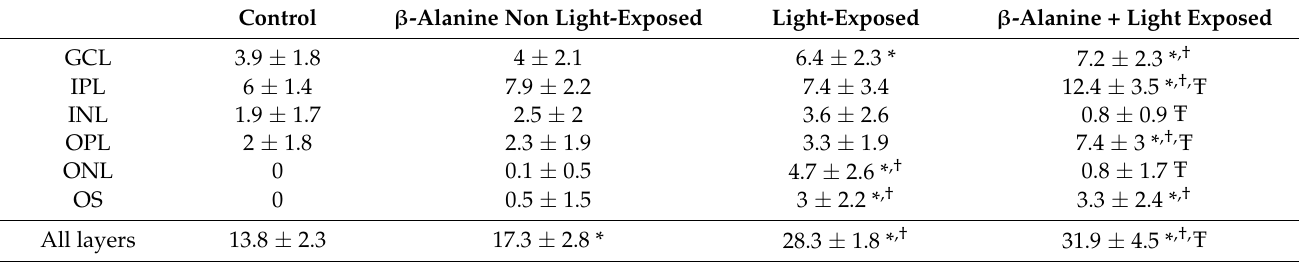
Table 3. Number of microglial cells per layer and total in control and experimental animals.